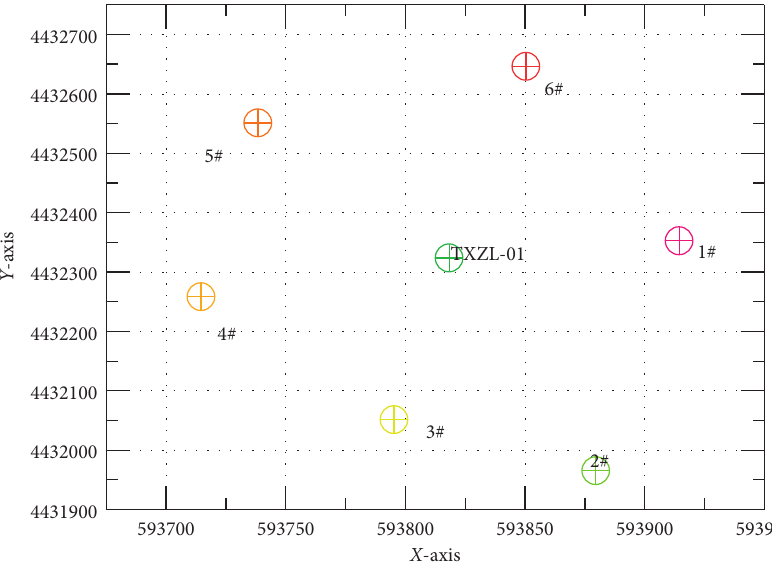
Figure 11: Coordinates of the station